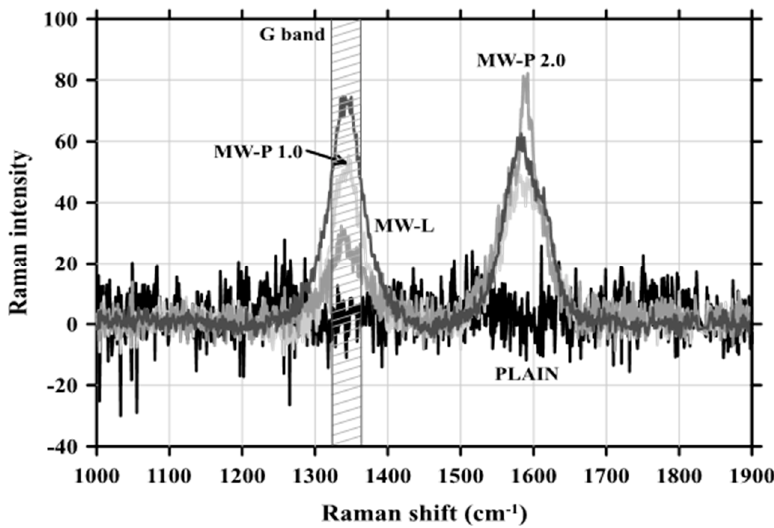
Figure 11. Raman spectrum.